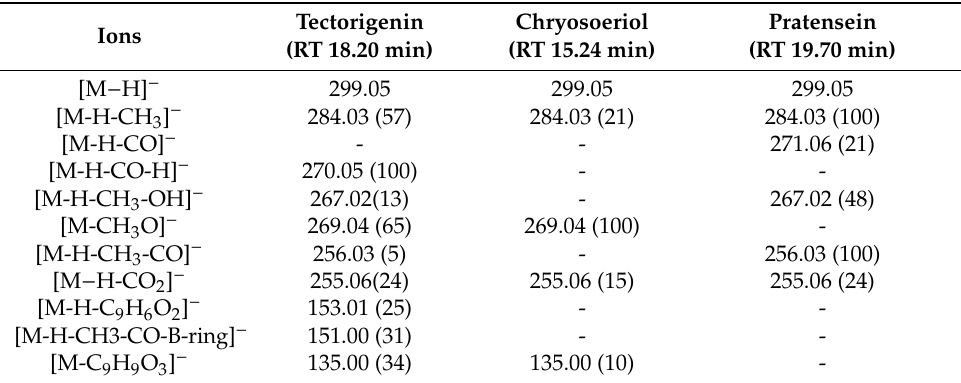
Table 4. Key ions in HRMS-MS spectra ( m / z with relative abundances (%) in parenthesis) for identifying tectorigenin A and